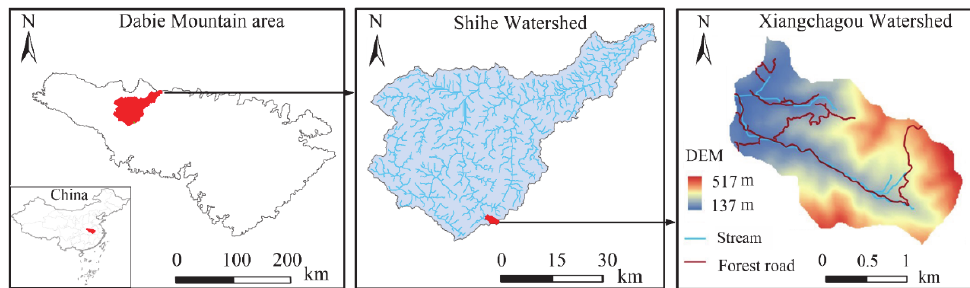
Figure 1. Location of the study area and distribution of forest roads and stream network.